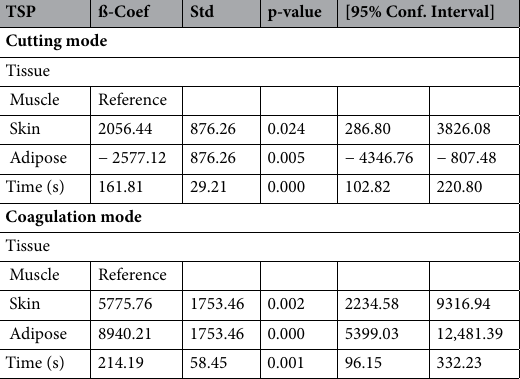
Table 2. Multiple linear regression analysis of the relation between tissue and duration of electrical diathermy with TSP. TSP total suspended particulates.